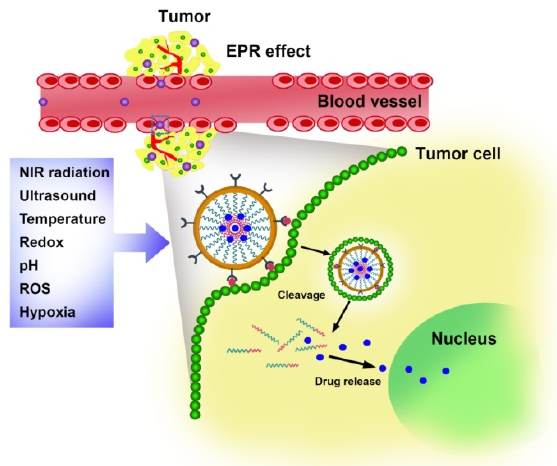
Figure 2. Stimuli responsive characteristics of polymersomes.